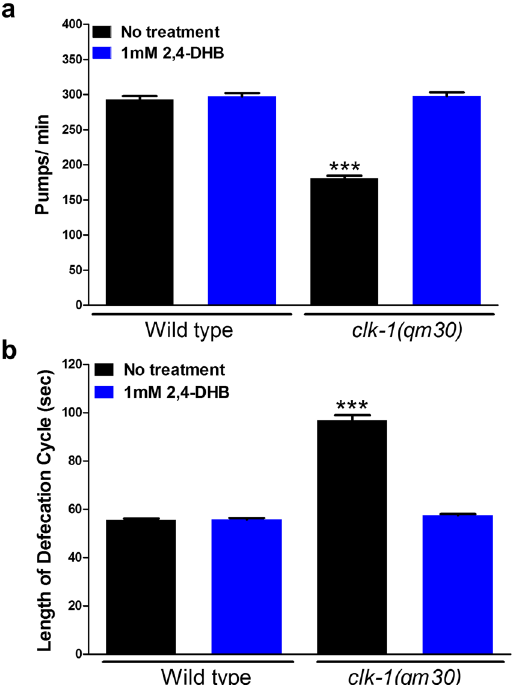
Figure 3. The behavioural defects of clk-1 ( qm30 ) mutants are fully rescued by 2,4-DHB. ( a ) clk-1 mutants pump at a significantly slower rate than the wild type. 1 mM 2,4-DHB fully rescues the slow pumping rates of clk-1 . At this concentration, 2,4-DHB had no effect on the wild type. The bars represent the mean number of pumps per minute. ( b ) clk-1 mutants have a significantly lengthened defecation cycle length. 1 mM 2,4-DHB fully rescues the slow defecation phenotype of clk-1 . 2,4-DHB had no effect on the wild type. The bars represent the mean defecation cycle of animals that have been scored for three consecutive defecation cycles each in the case of non-treated clk-1 ( qm30 ) mutants and for five consecutive defecation cycles for all the other conditions. The error bars represent S.E.M. (n ≥ 20 animals for each condition). The asterisks indicate that the data are significantly different from that of the wild-type. All differences were significant at p < 0.0001 by a